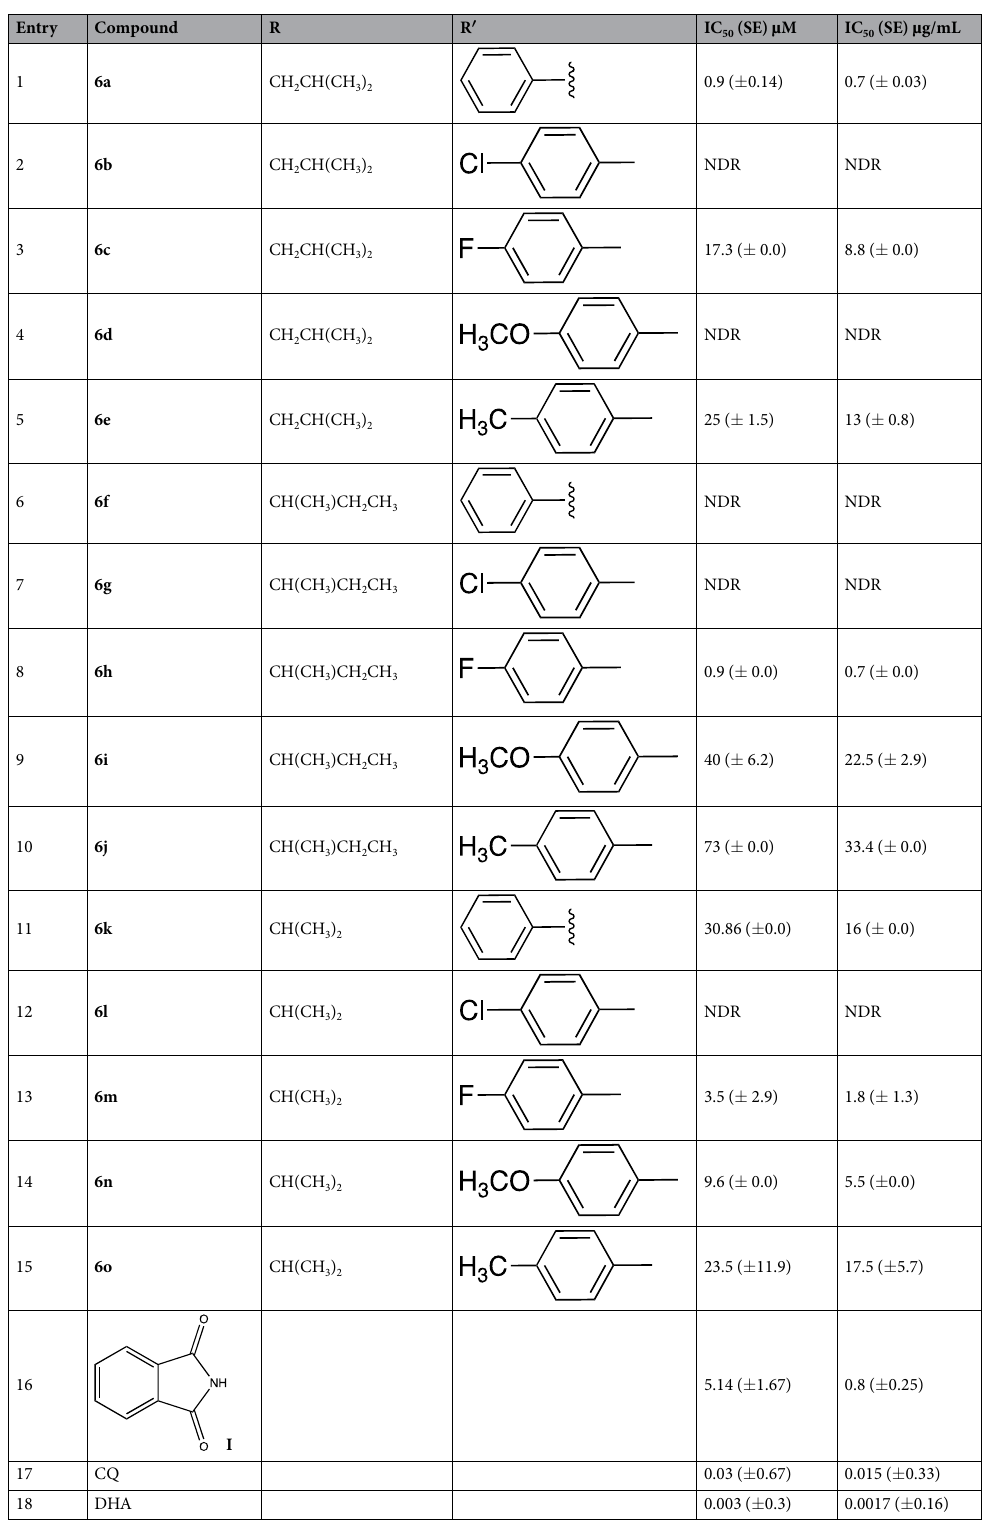
Table 1. SAR Study of R ′ Substituent: Aromatic Rings. Note: Illustration of Pht analogues, Pht (I), and chloroquine and dihydroartemisinin IC 50 values. IC 50 value < 5.14 µ M: active and IC 50 value > 5.14 µ M: